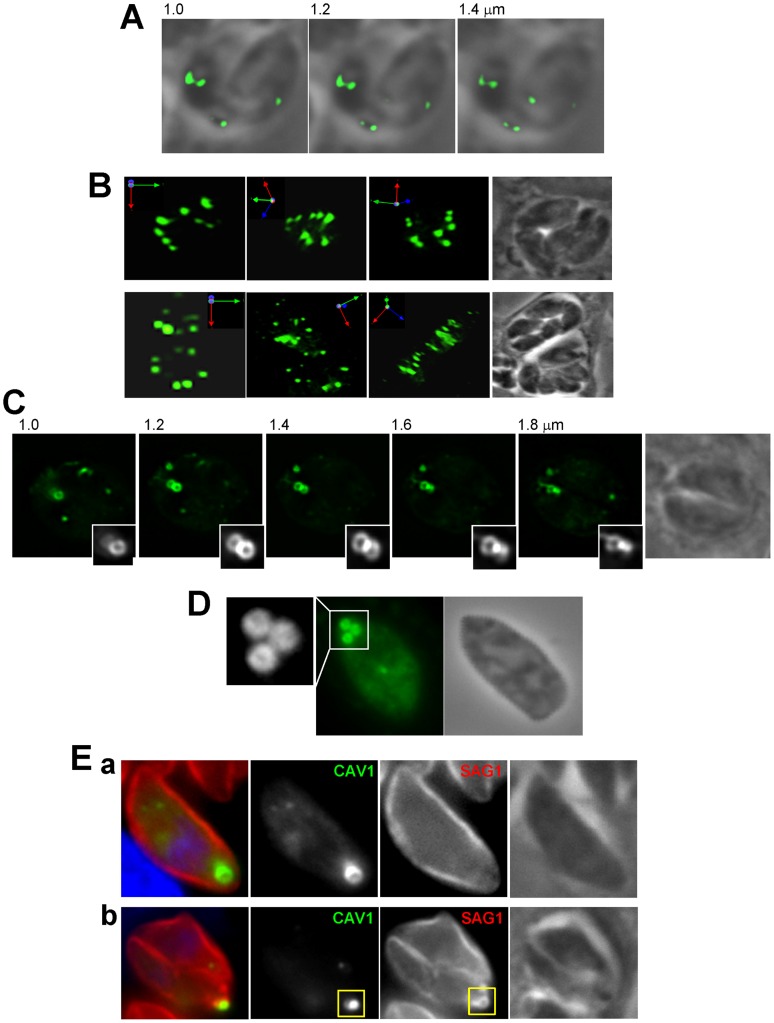
Morphological characterization of CAV1-containing vesicles in transgenic Toxoplasma. (A–E) Direct fluorescence microscopy of intracellular Toxoplasma expressing CAV1-YFP illustrating the distribution of CAV1-containing vesicles within the parasite. (A) Images show individual z-slices from a z-series of fluorescence images. The images are shown with the fluorescence signal overlaying the corresponding phase contrast picture. (B) 3-D reconstructions of z-stacks of CAV1-labeled vesicles and rotated views of the images are shown. (C) Series of z-stacks of intracellular transgenic parasites revealing large CAV1-labeled vesicles with an annular staining pattern. (D) Series of z-stacks of extracellular transgenic parasites showing large CAV1-labeled vesicles with similar pattern as in C. (E) Toxoplasma expressing CAV1-YFP immunolabeled with antibodies against SAG1 (marker for the plasma membrane) show representative examples of CAV1-containing vesicles that are distant from the plasma membrane (panel a) or surrounded by the plasma membrane (panel b), which is forming residual body shown in the square.